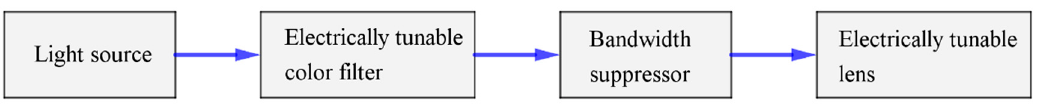
Figure 17. Schematic representation of the optical system for low-level laser therapy (LLLT).